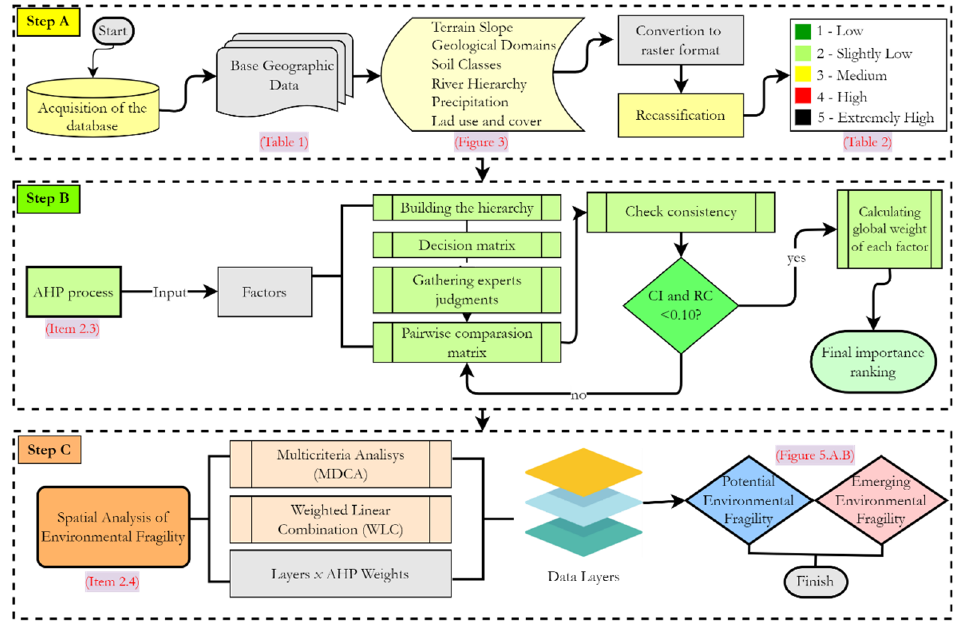
Figure 4. Flowchart of the methodological procedures for analyzing the potential and emerging en- vironmental fragility.